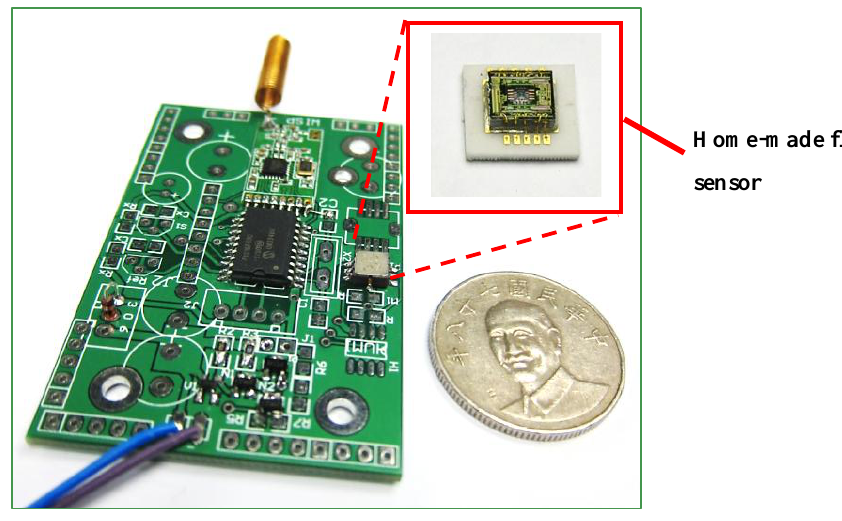
Figure 8. The flow sensor module uses a home-made flow sensor.